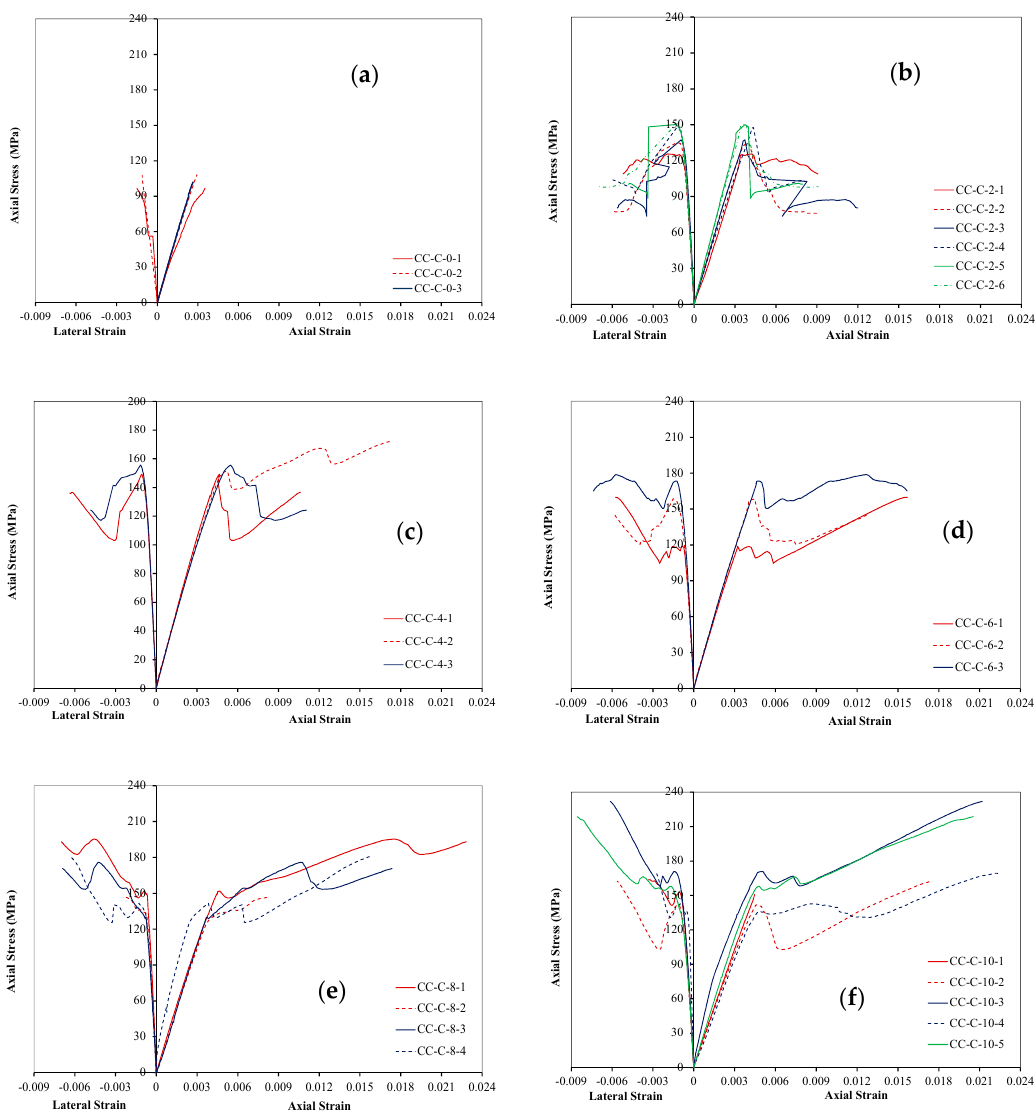
Figure 2. Axial stress–strain curves of HPFRCC specimens: ( a ) unconfined; ( b ) confined by two layers of CFRP; ( c ) confined by four layers of CFRP; ( d ) confined by six layers of CFRP; ( e ) confined by eight layers of CFRP; and ( f ) confined by ten layers of CFRP.